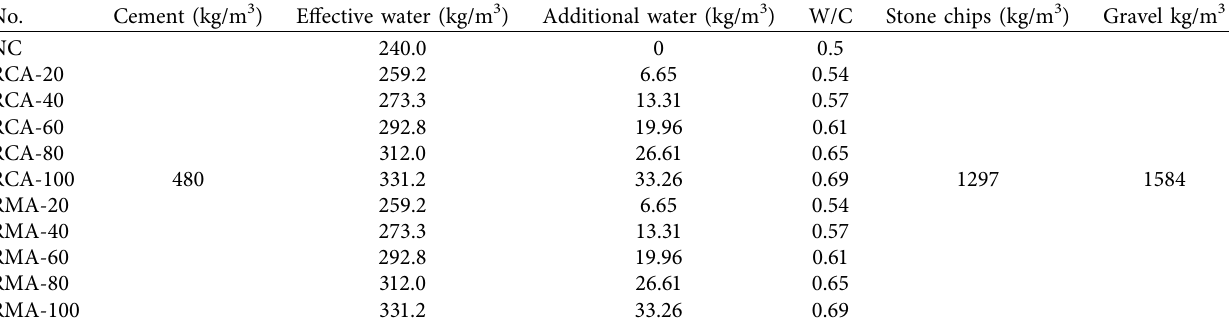
Table 5: The mixing proportion of CCG and